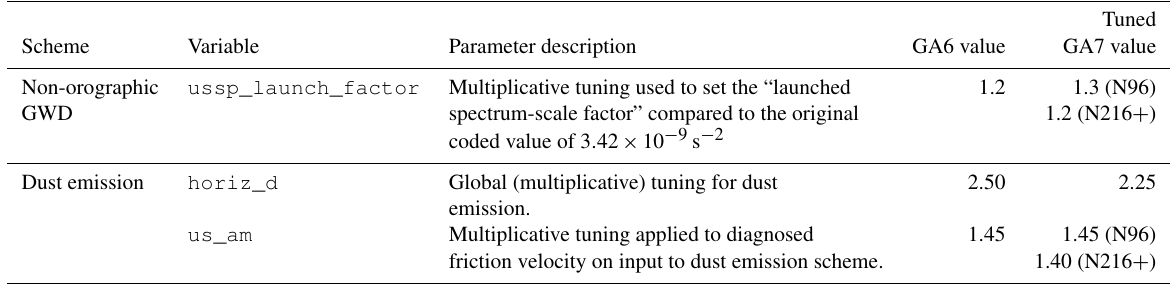
Table 6. Original GA6.0 and final GA7.0 values of parameters in schemes routinely tuned as part of GA development.